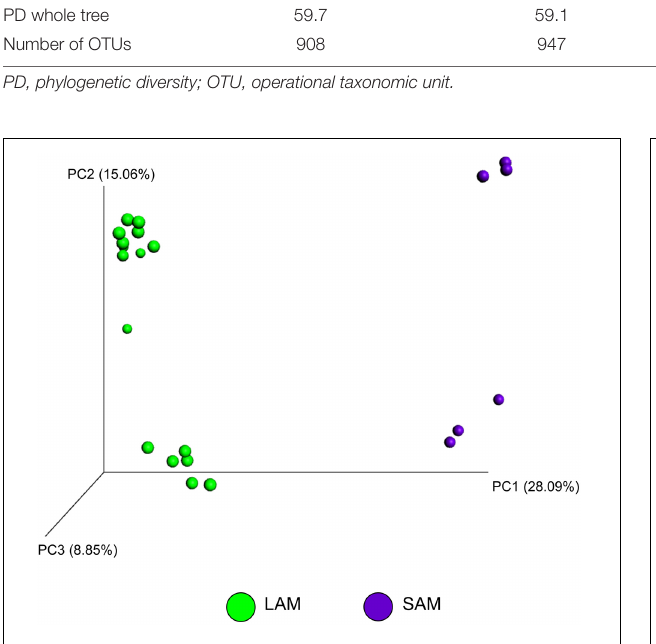
FIGURE 3 | Principal coordinate analysis (PCoA) of the unweighted UniFrac distances for SAM and LAM samples. The percent variation explained by each principal coordinate is indicated on the axes. Original rumen samples are excluded. LAM, liquid-associated microbes; SAM, solid-associated microbes.